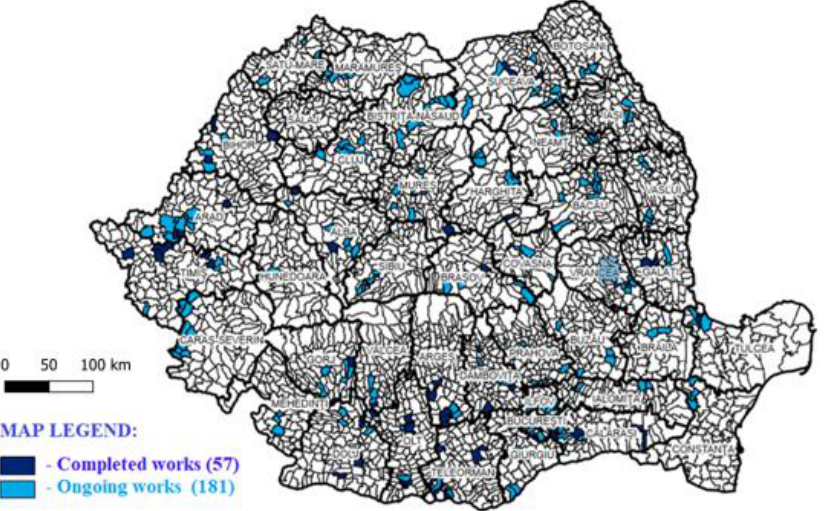
Figure 3. Current Situation in the Romanian General Cadastre.